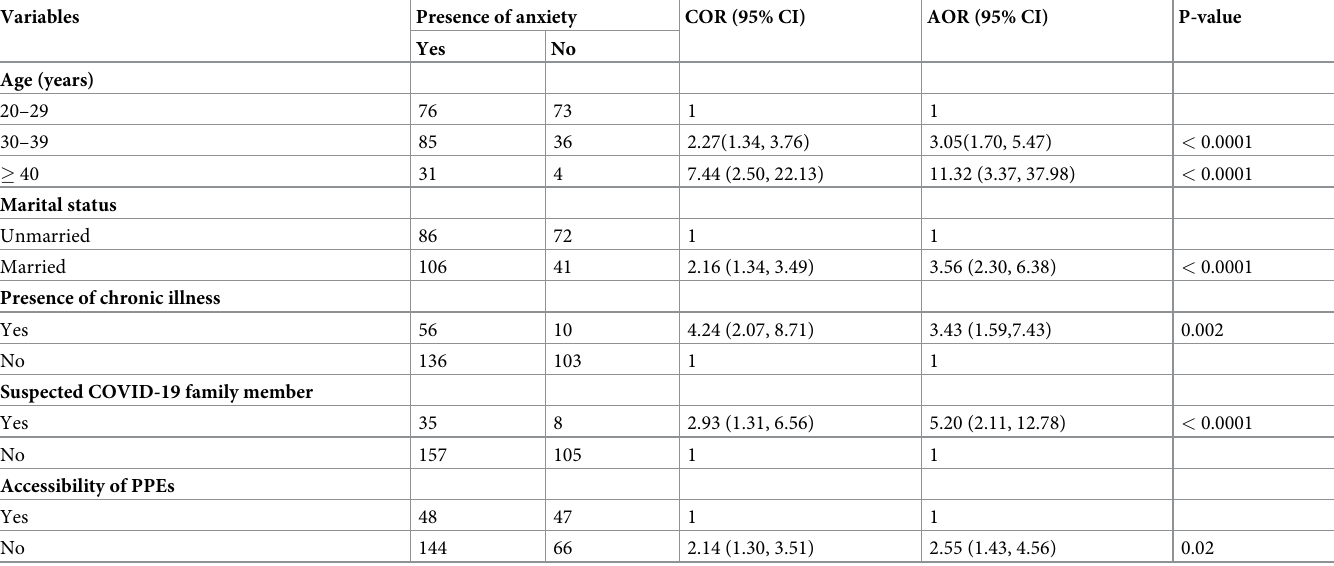
Table 3. Bivariate and multivariate analysis of factors associated with anxiety of COVID-19 among HCWs at a Hospital of